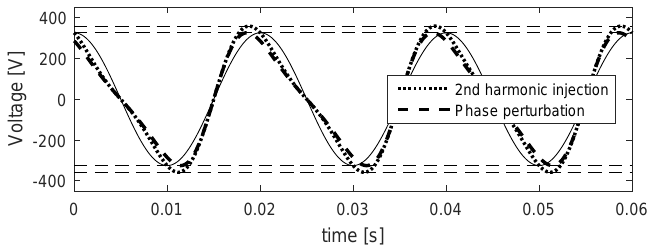
Figure 13. Magnified effect of phase perturbation distortion with k =